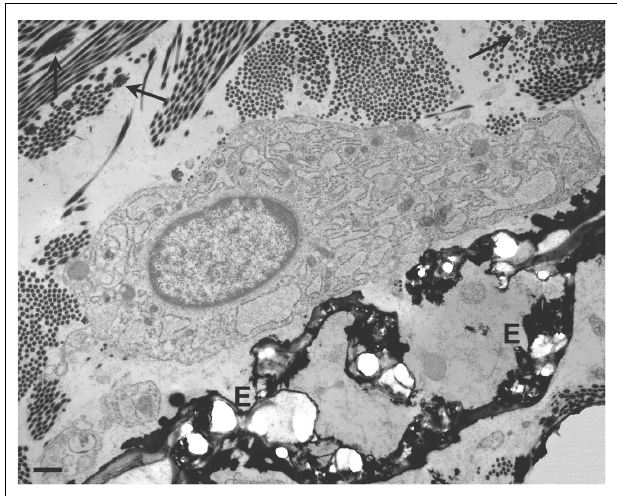
FIGURE 2 |Transmission electron microscopy of a dermal biopsy from a patient affected by pseudoxanthoma elasticum (PXE). Deformed calcified elastic fibers (E) are present in close proximity to large fibroblasts with abundant and dilated cisternae of the endoplasmic reticulum. Collagen fibrils occasionally organized into collagen flowers (arrows) are also visible. Bar = 1 μ